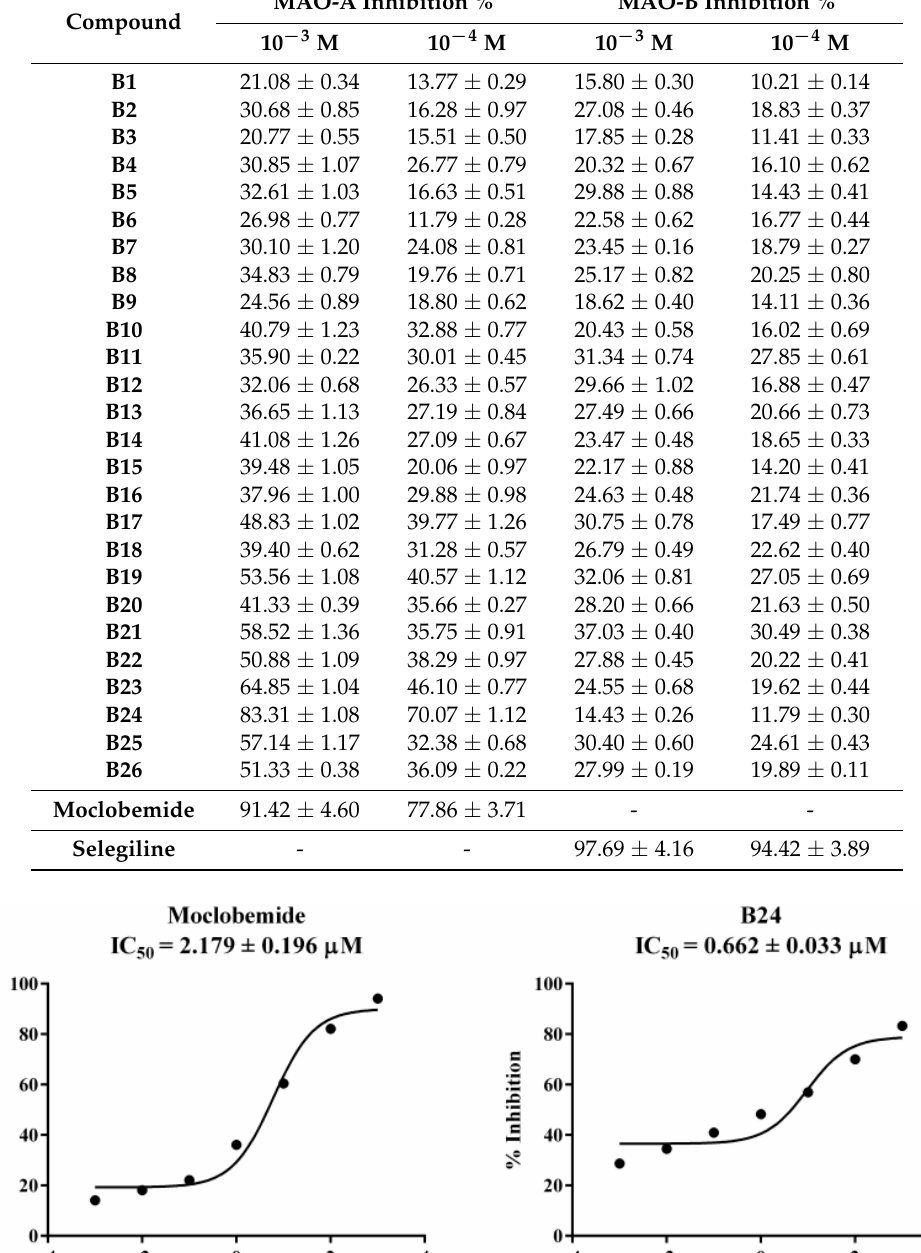
Table 1. Initial screening results to determine inhibition potency of compounds B1 – B26 , moclobemide and selegiline against monoamine oxidase A (MAO-A) and monoamine oxidase B (MAO-B) at concentrations of 10 − 3 M and 10 − 4 M.